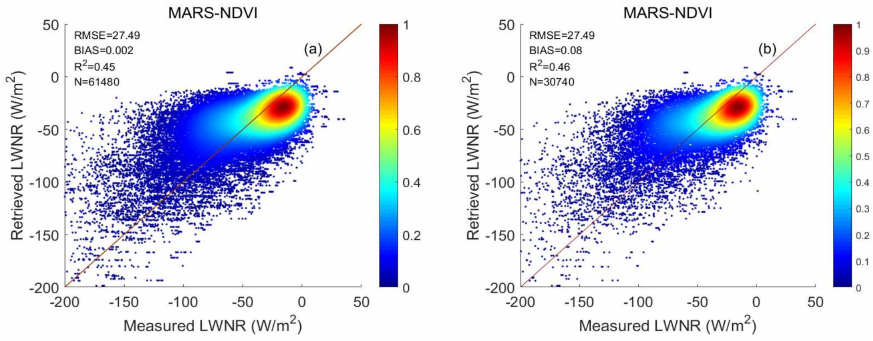
Figure 6. Accuracy of MARS-NDVI model: ( a ) training results and ( b ) validation results.